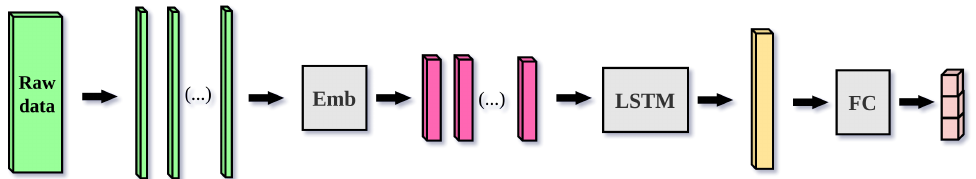
Figure 8. Raw data classifier based on the long short term memory network. Since the LSTM is a sequential model, the input matrix with dimensions (1024, 30) is processed as a sequence of 30 vectors with size 1024. Each 1024-dimensional input vector is embedded into a 256-dim representation by a learned embedding layer (Emb). The dimension of the hidden state is 256. The bidirectional LSTM network aggregates the input sequence by processing it in two directions and concatenating the final hidden states for both directions. As with the fully connected classifier, the resulting vector is given to a fully connected classifier with the sigmoid activation function, which the three posterior probability